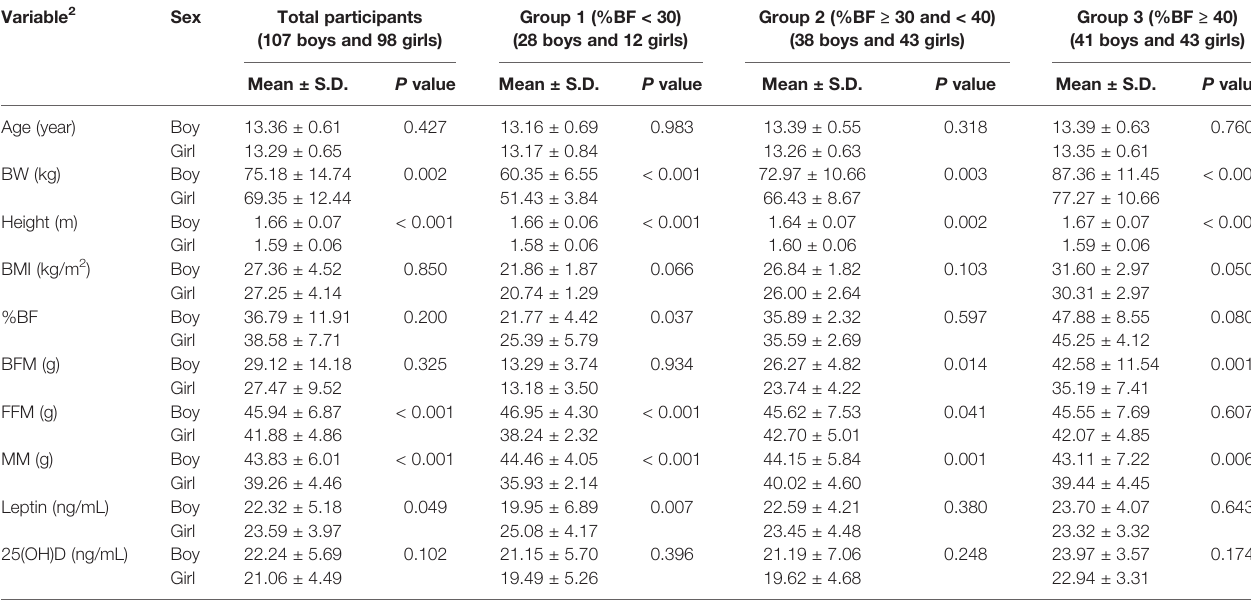
TABLE 1 | Characteristics of study participants and comparisons 1 of the variables between boy and girl. Variable